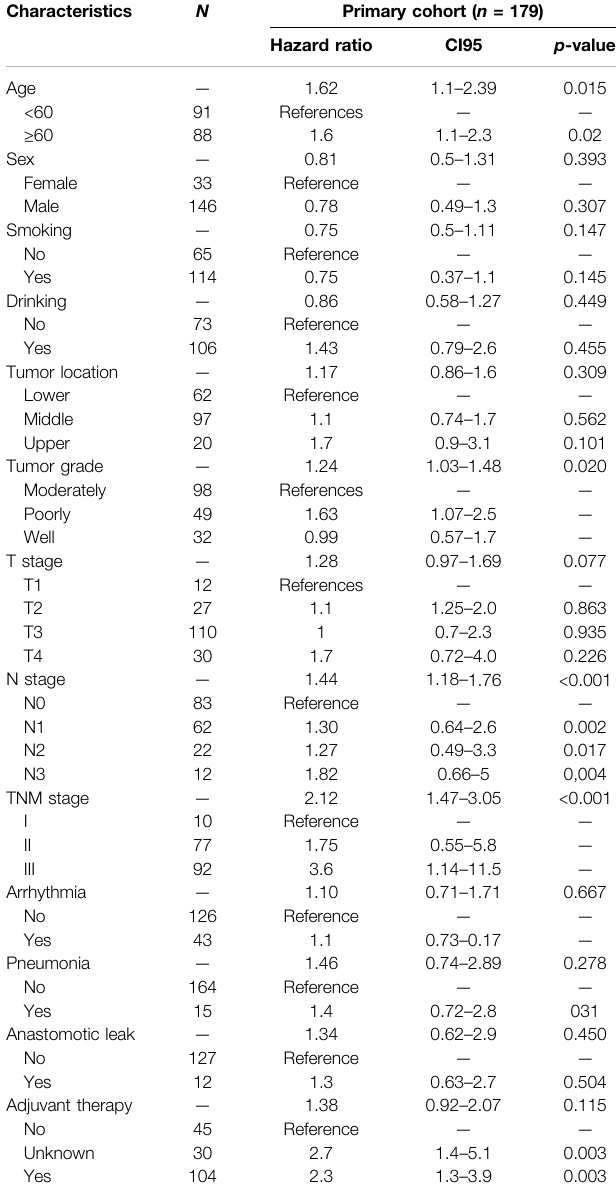
TABLE 1 | Demographics and clinicopathologic characteristics of patients with